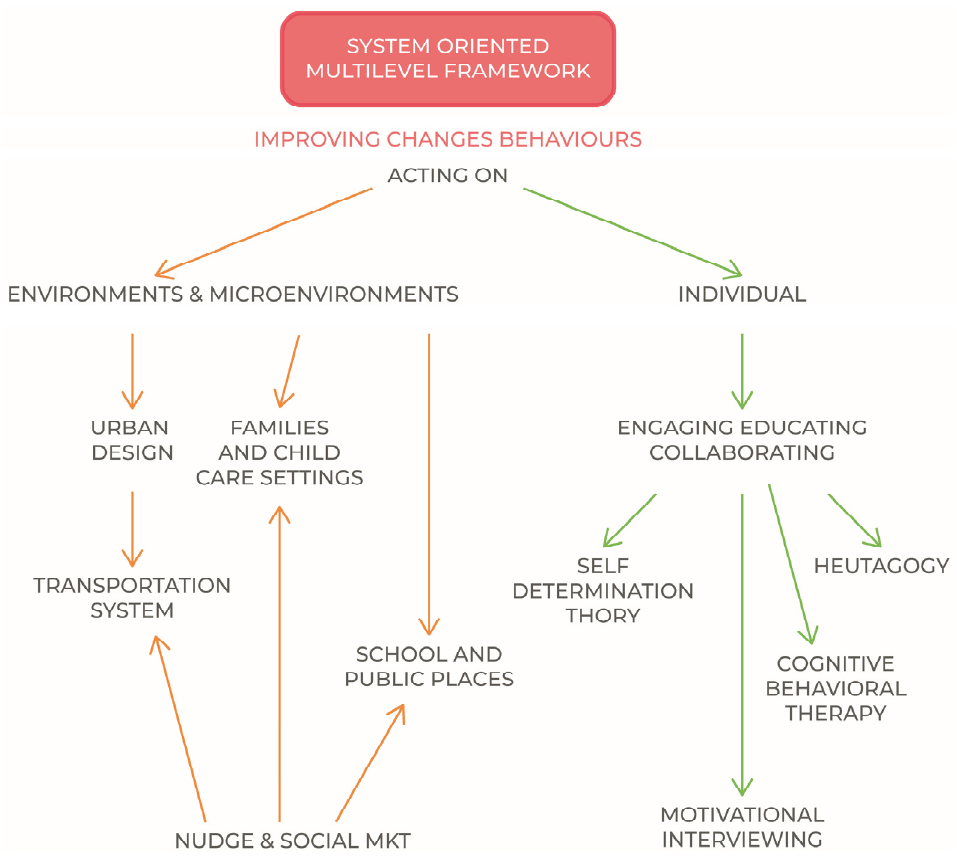
Figure 4. A system oriented multilevel